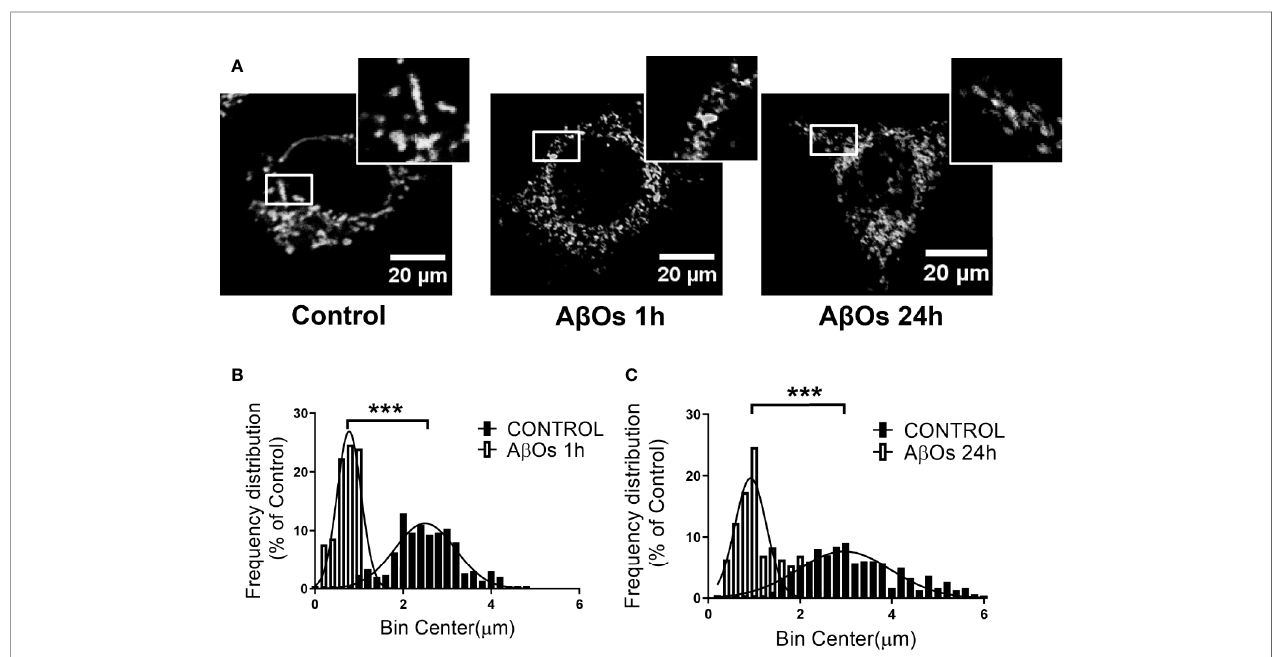
FIGURE 4 | Changes in mitochondrial network size after acute and chronic exposure to A b Os in PC12-cells. (A) Confocal images of PC-12 cells showing immunoreactivity of the speci fi c primaryantibody for TOM 20 (white) in control conditions (left panel) and after A b Os treatments (0.5 µM) during 1 and 24 h of incubation (middle panel and right panel, respectively). White squares show a magni fi cation of the soma region of the cell). (B) Histogram shows the mitochondrial size distribution after acute and (C) chronic treatments with A b Os. Data are represented as mean ± SEM. ***p < 0.001 compared between the control group. Student's t-test followed by Mann-Whitney test was used for all statistical analyses. TOM20, translocase of outer membrane. (n=3, N=18 – 23) (complete inmunocytochemistry for TOM20 with control are provided on Supplementary Figure 4